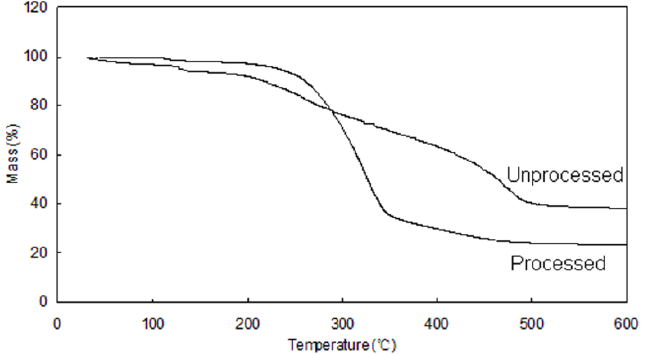
Figure 6. Comparative investigations on TG of unprocessed and processed GTW.